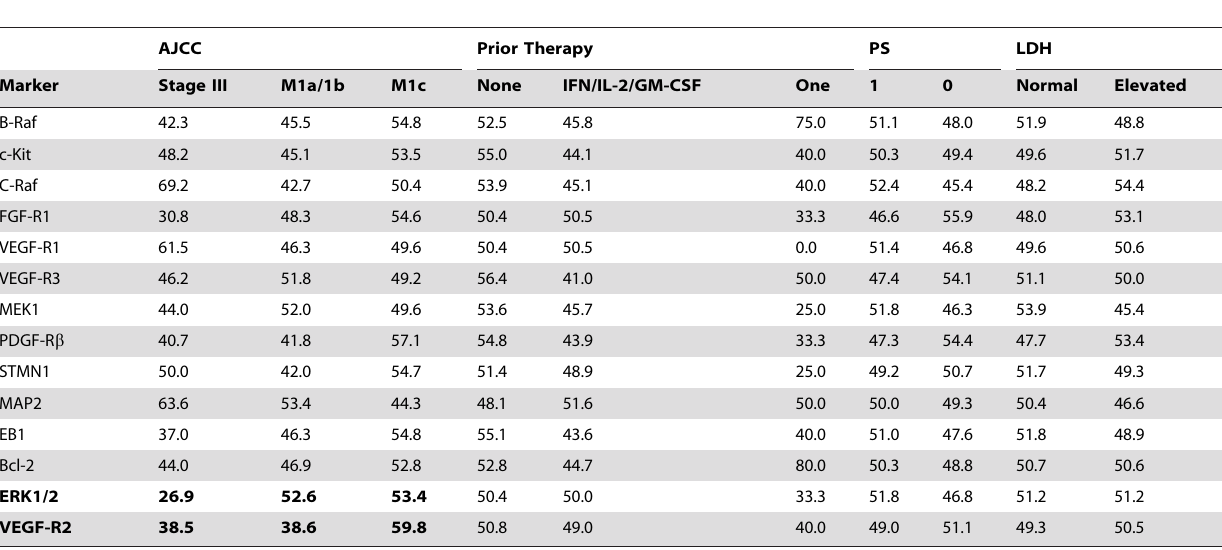
Table 3. Percentage of tumors with high expression for each biomarker by clinical parameters (AQUA scores dichotomized at the median).